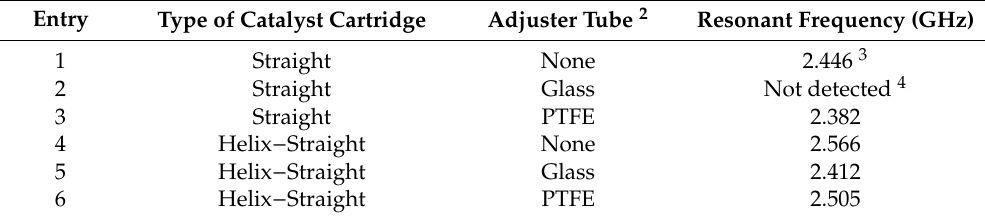
Table 1. Resonance frequency depending on catalyst cartridges and adjustor tubes 1